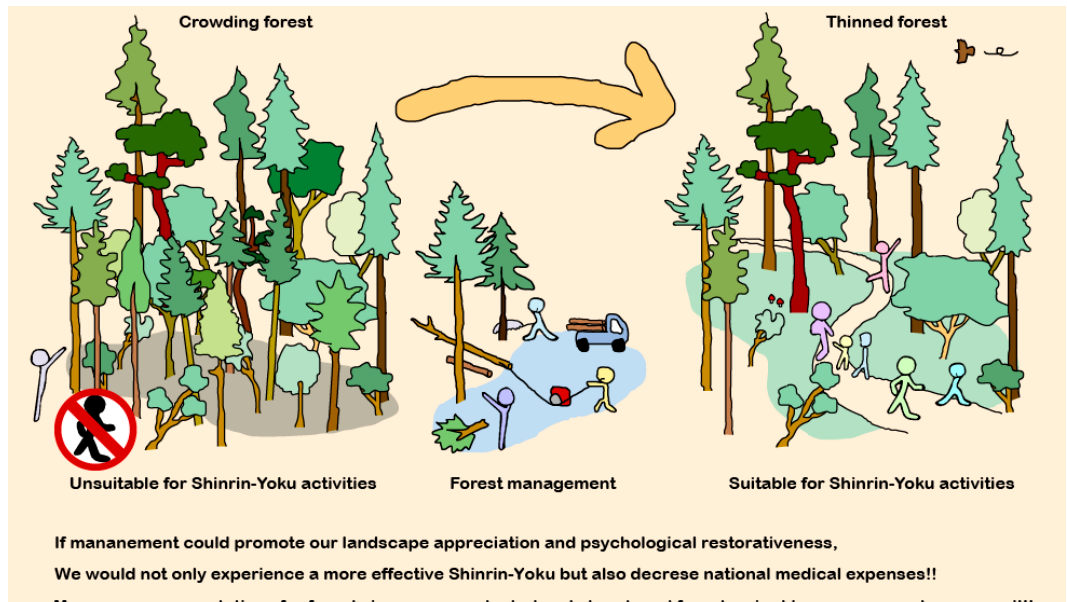
Figure 1. Forest management and our health.